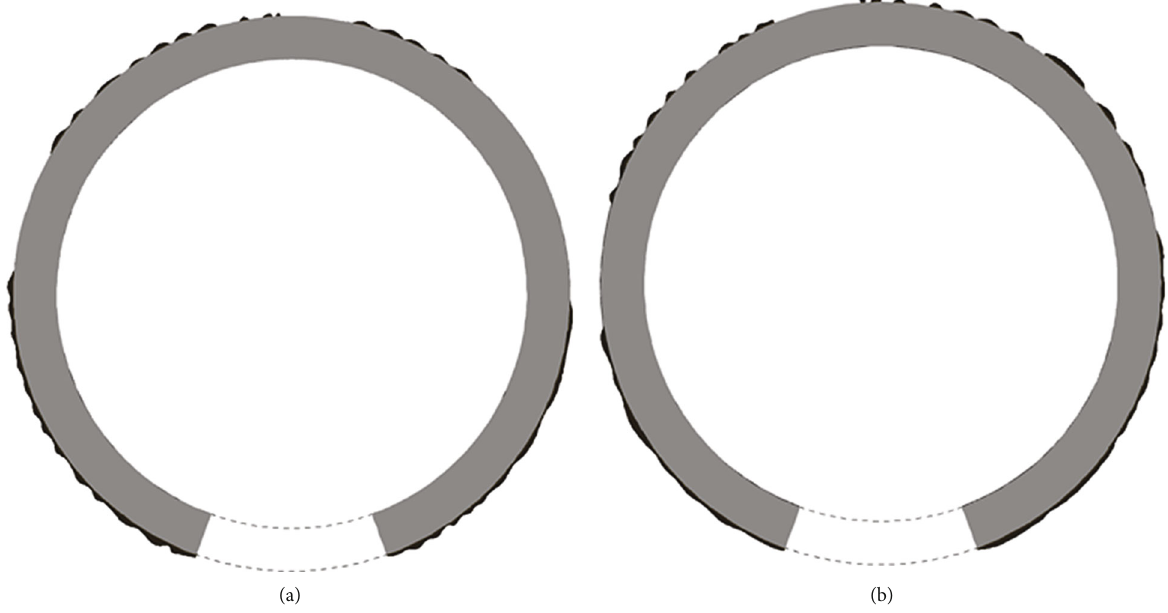
Figure 10: Prediction diagram of slurry grouting distribution. (a) The fourth segment. (b) The fi fth